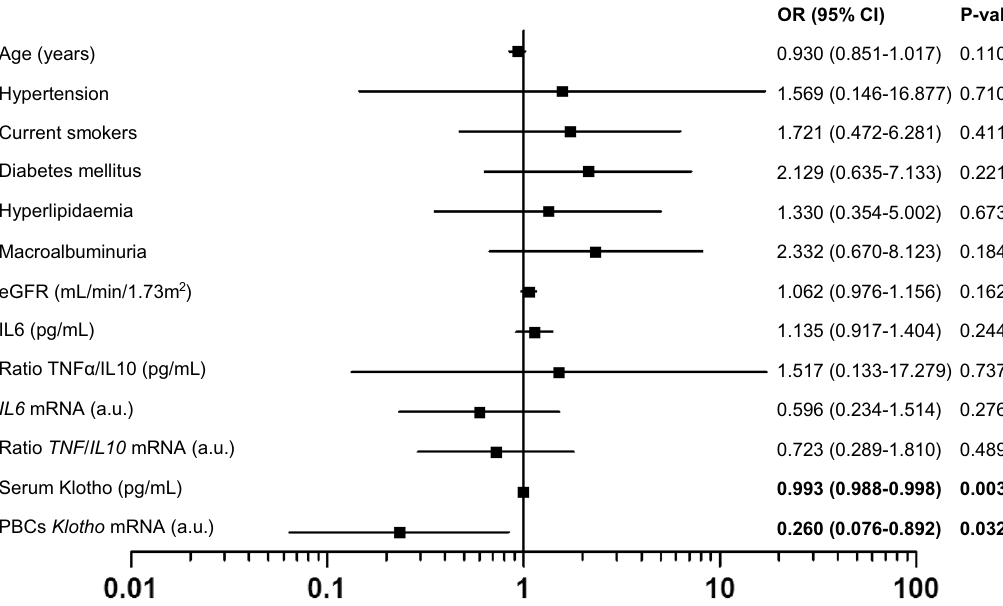
Figure 1. Multivariate odds ratio for subclinical atherosclerosis displayed as the odds ratio (OR) with 95% confidence intervals